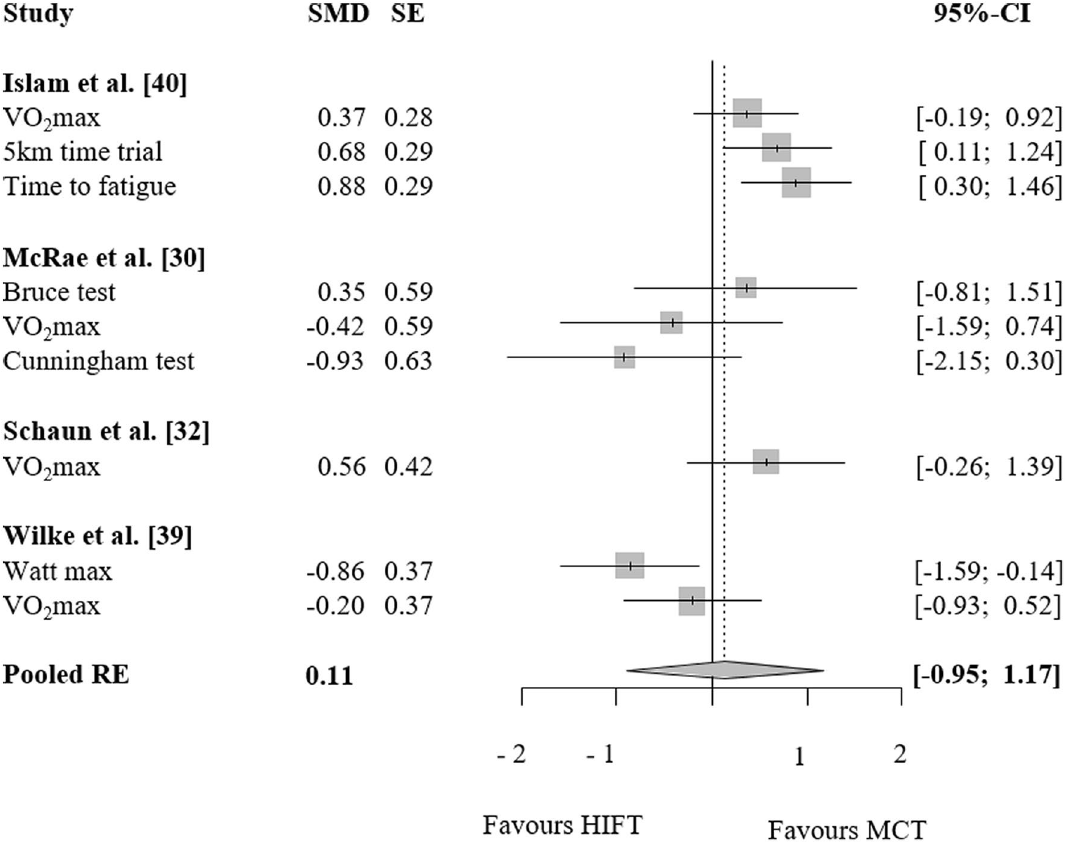
Figure 5. Effects of high-intensity-functional training (HIFT) vs. moderate continuous aerobic training (MCT) on markers of endurance. Forest plots with pooled standardized mean differences (SMD), standard errors (SE) and 95% confidence intervals (CI) are displayed. RE random effects.